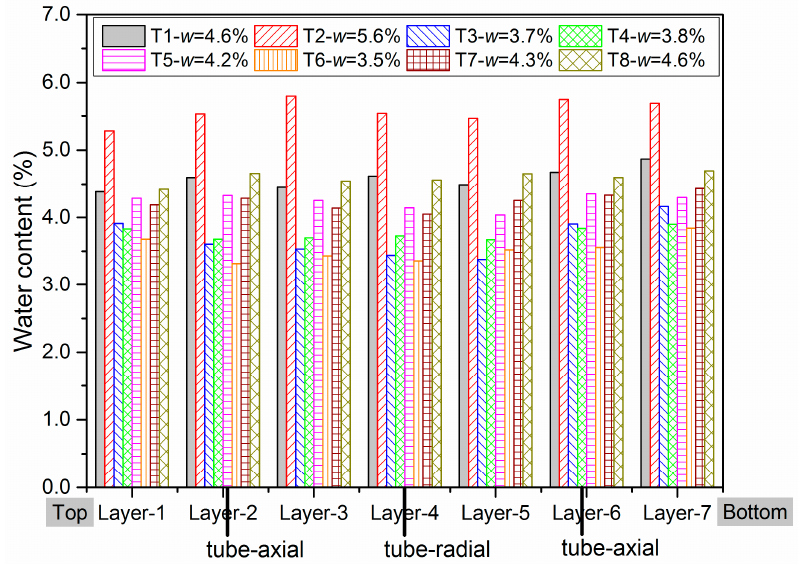
Figure 17. Water distribution in seven layers in each sample.